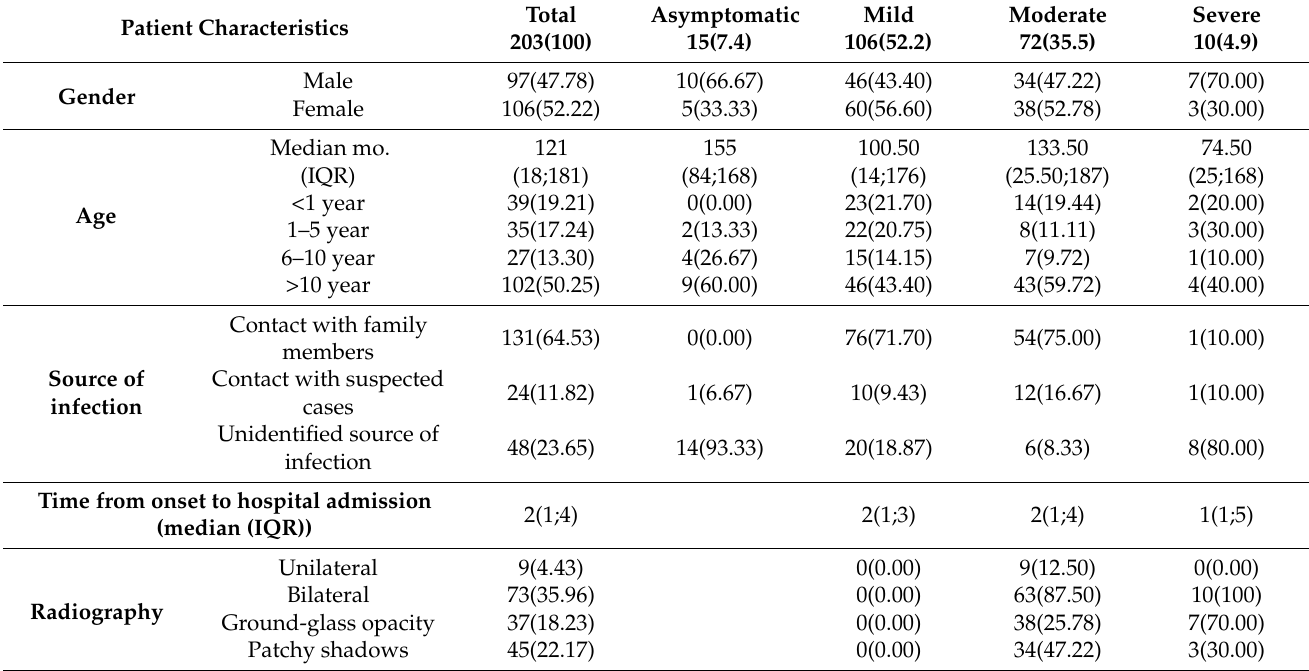
Table 1. Characteristics of patients on admission, stratified by clinical types. Patient